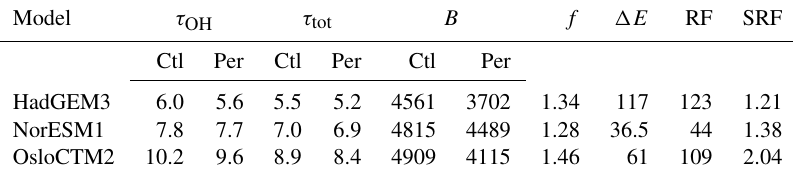
Table 7. Characteristics of the methane budget in ECLIPSE models. For NorESM1, numbers are given for the summer perturbation sim- ulation. From left to right, columns give methane lifetime to destruction by OH ( τ OH ), in years, for the control (Ctl) and perturbed (Per) simulations; total methane lifetime ( τ tot ), in years, in Ctl and Per simulations; total methane burden ( B ), in Tg[CH 4 ], in Ctl and Per simu- lations; methane feedback factor ( f ); equivalent methane emission perturbation ( (cid:49)E ), in Tg[CH 4 ]yr − 1 ; methane radiative forcing (RF),